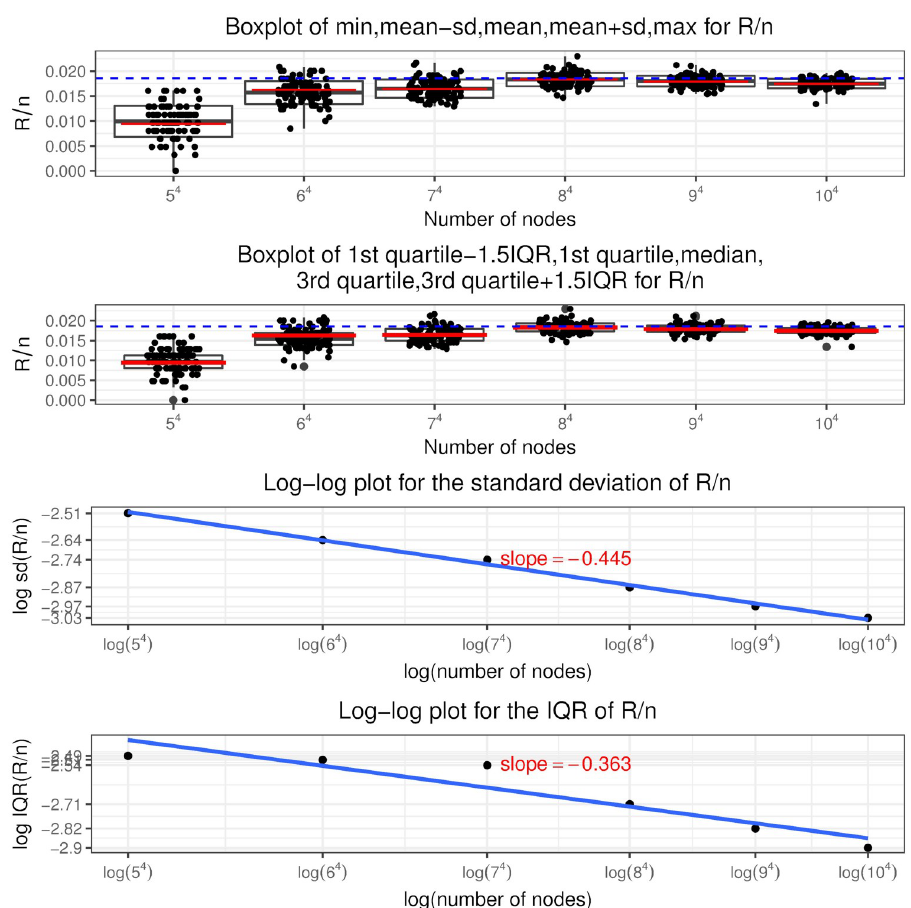
Fig 9. The boxplot and log-log plot of standard deviation and IQR for R / n under alternative policy.